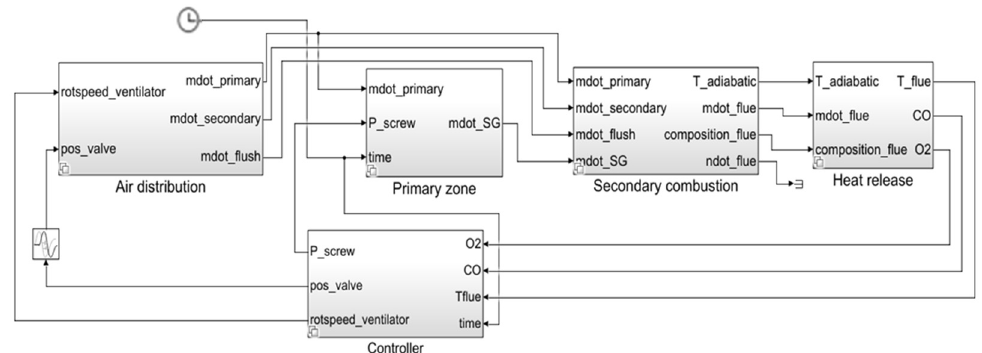
Figure 2. MATLAB–Simulink model of the digital twin.